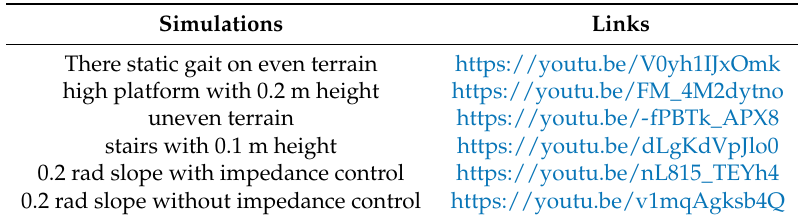
Table 2. Simulation video links.